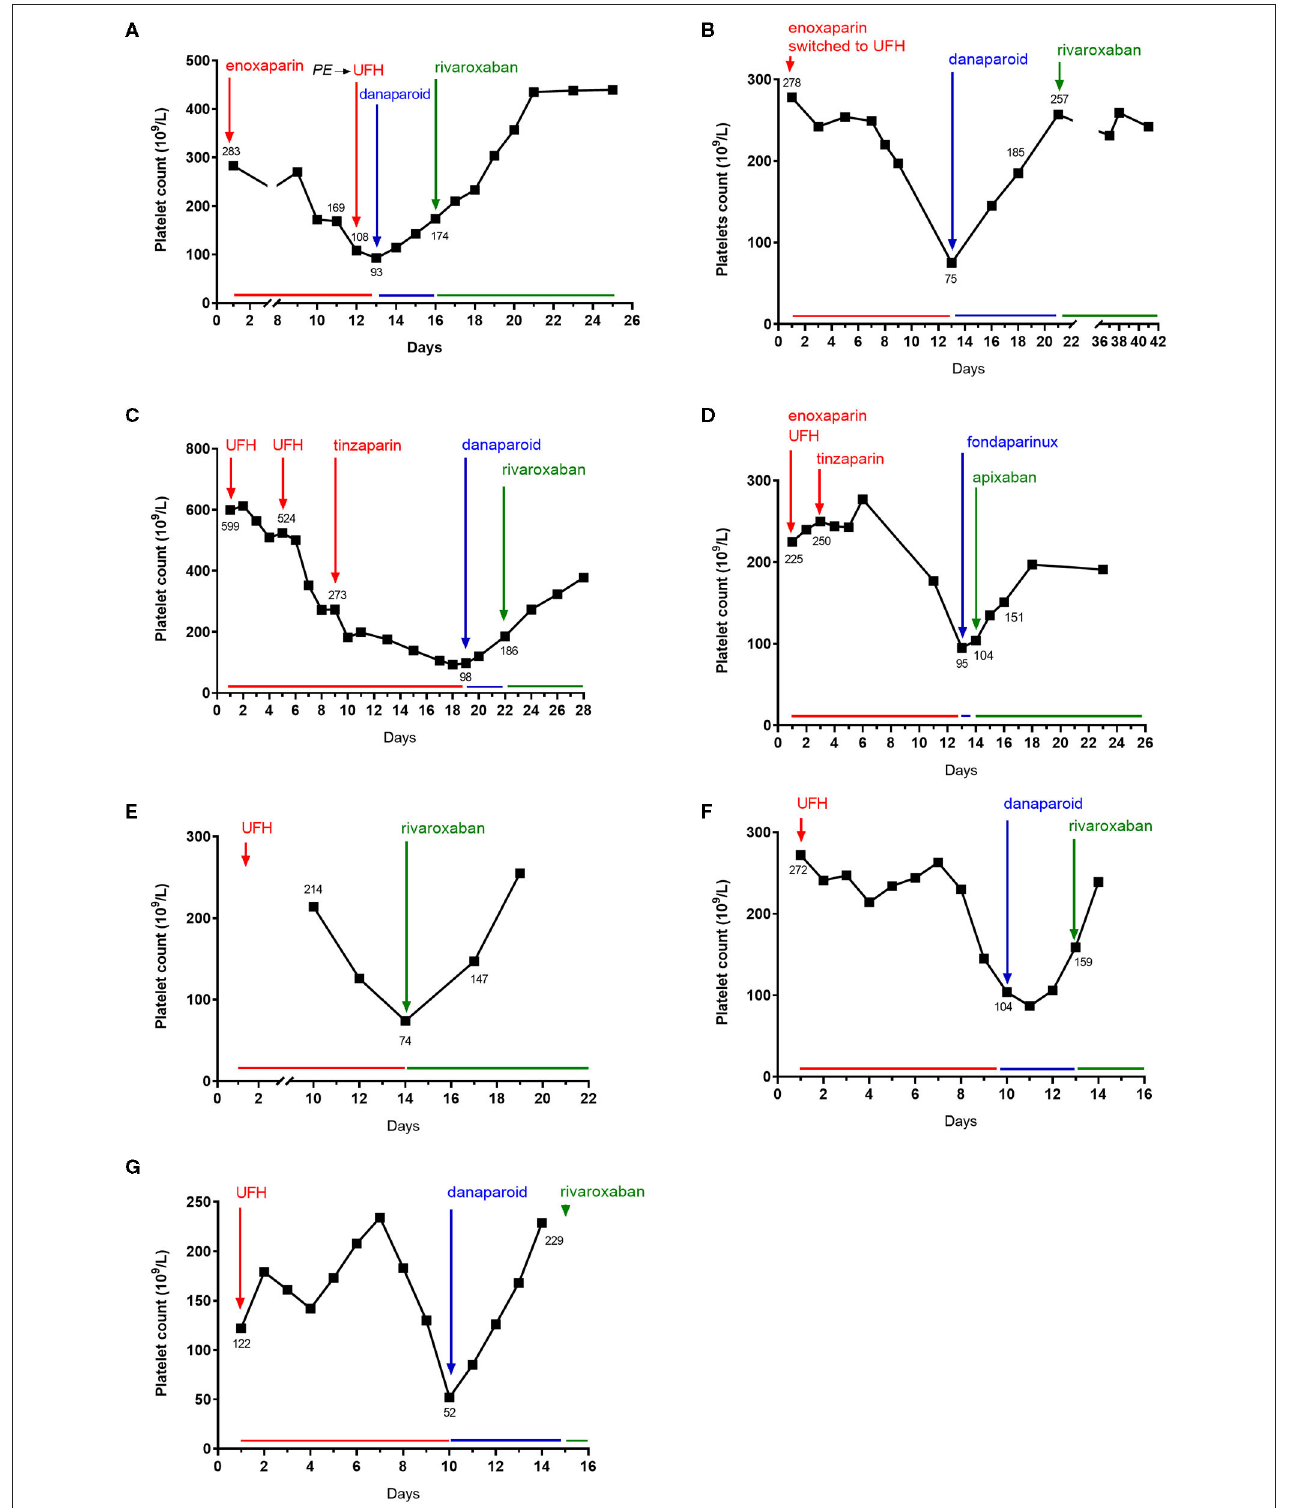
FIGURE 1 | Platelet count evolution over time after heparin initiation. Day 1 as the first day unfractionated heparin (UFH) or low molecular weight heparin treatment (LMWH) administration. (A–G), respectively, represent patients #1 to #7.